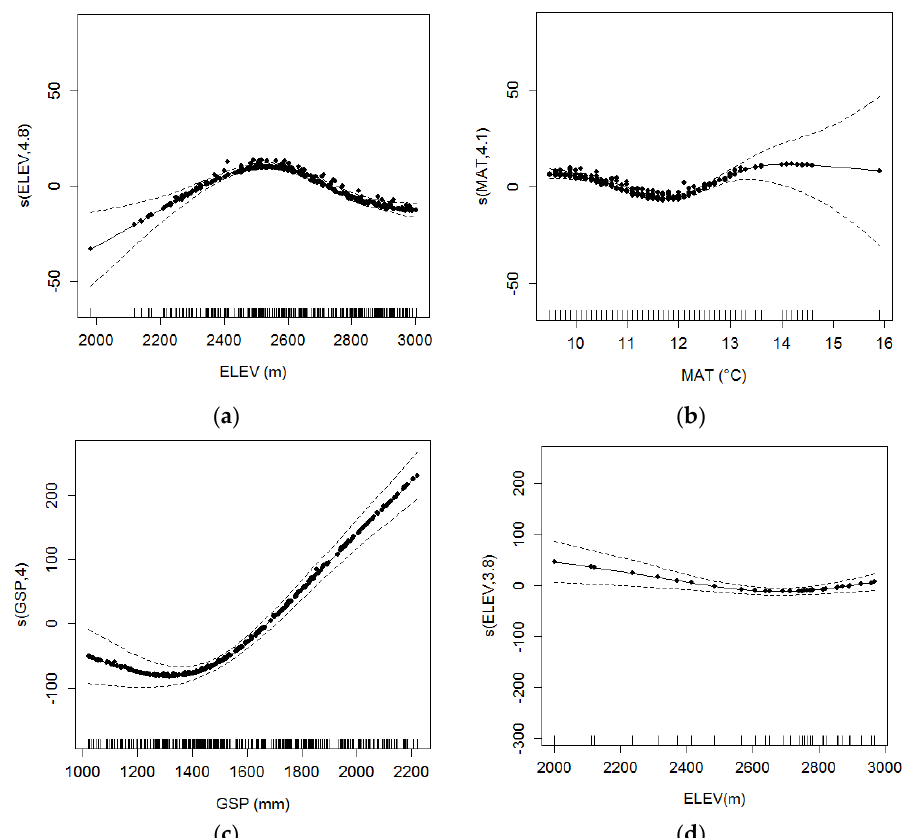
Figure 2. Response of abundance rate of: ( a ) Pinus pseudostrobus to the smooth function f(ELEV) ; ( b ) Pinus pseudostrobus to the f ( MAT ); ( c ) Pinus patula to the f ( GSP ) and ( d ) Quercus macdougallii to the f ( ELEV ). Dashed lines indicate the point-wise standard errors for each smoothing term with a 95% confidence interval (CI). The values on the vertical axis are estimated degrees of freedom.